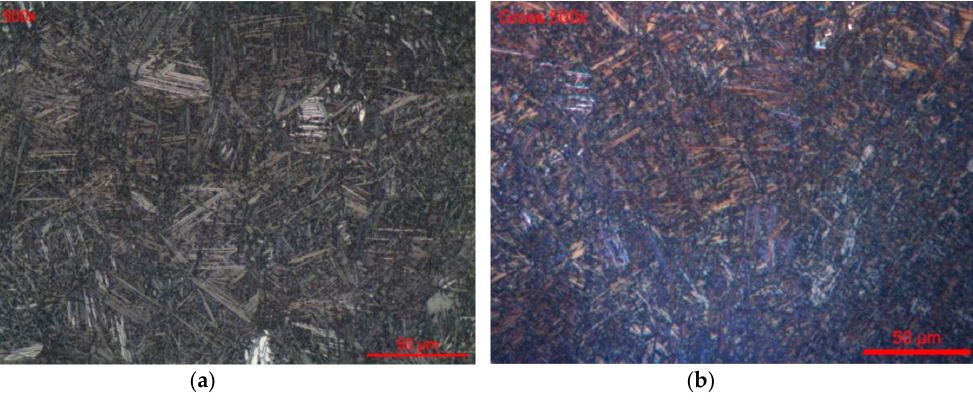
Figure 8. Ti45Nb alloy microstructure (#3): longitudinal section ( a ) OM and ( b ) SEM images;(#4): transversal section ( c ) OM and ( d ) SEM images.